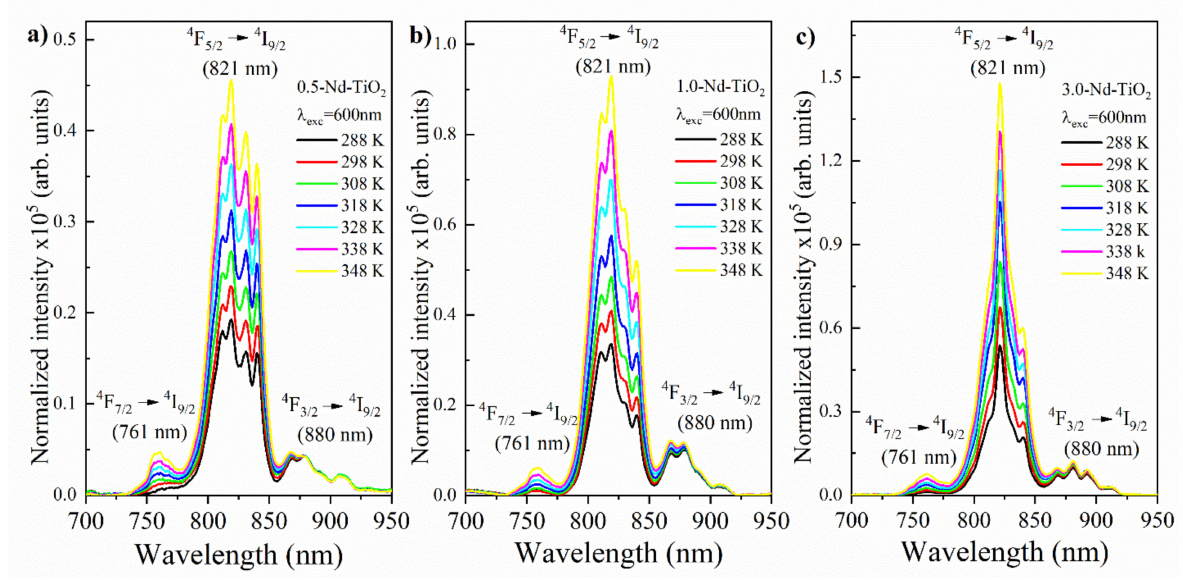
Figure 6. Temperature evolution of the emission spectra of ( a ) 0.5-Nd–TiO 2 , ( b ) 1-Nd–TiO 2 and ( c ) 3-Nd–TiO 2 after excitation at 600 nm. The 4 F 3/2 → 4 I 9/2 transition intensity at 880 nm was normalized for all samples. The spectra were not corrected for the detector response curve. All spectra were acquired with integration time equal to 1 s.